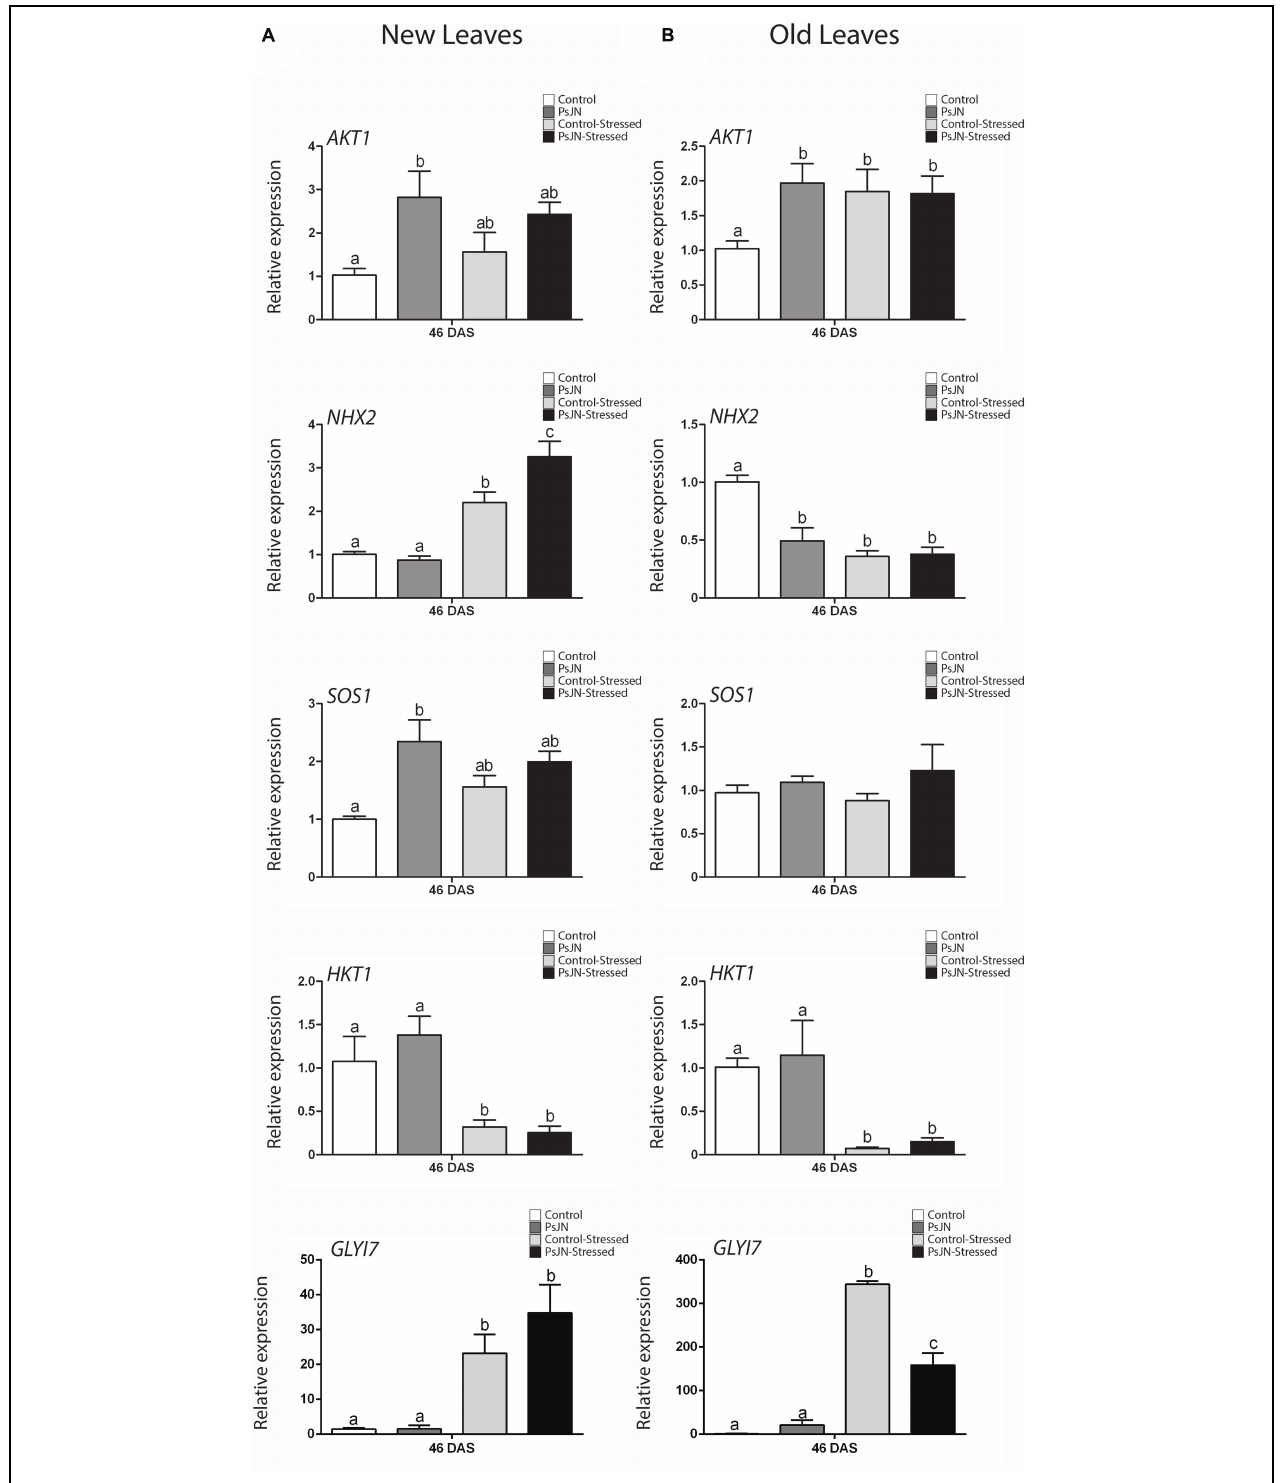
FIGURE 7 | Effect of B. phytofirmans PsJN on A. thaliana salt-stress related genes transcription after long-term exposure to salt stress. Quantitative RT-PCR determinations of relative expression levels of the genes: AKT1 ; NHX2 ; SOS1 ; HKT1 , and GLYI7 , in new (A) and old leaves (B) of A. thaliana plants treated with or without strain PsJN, and transplanted at